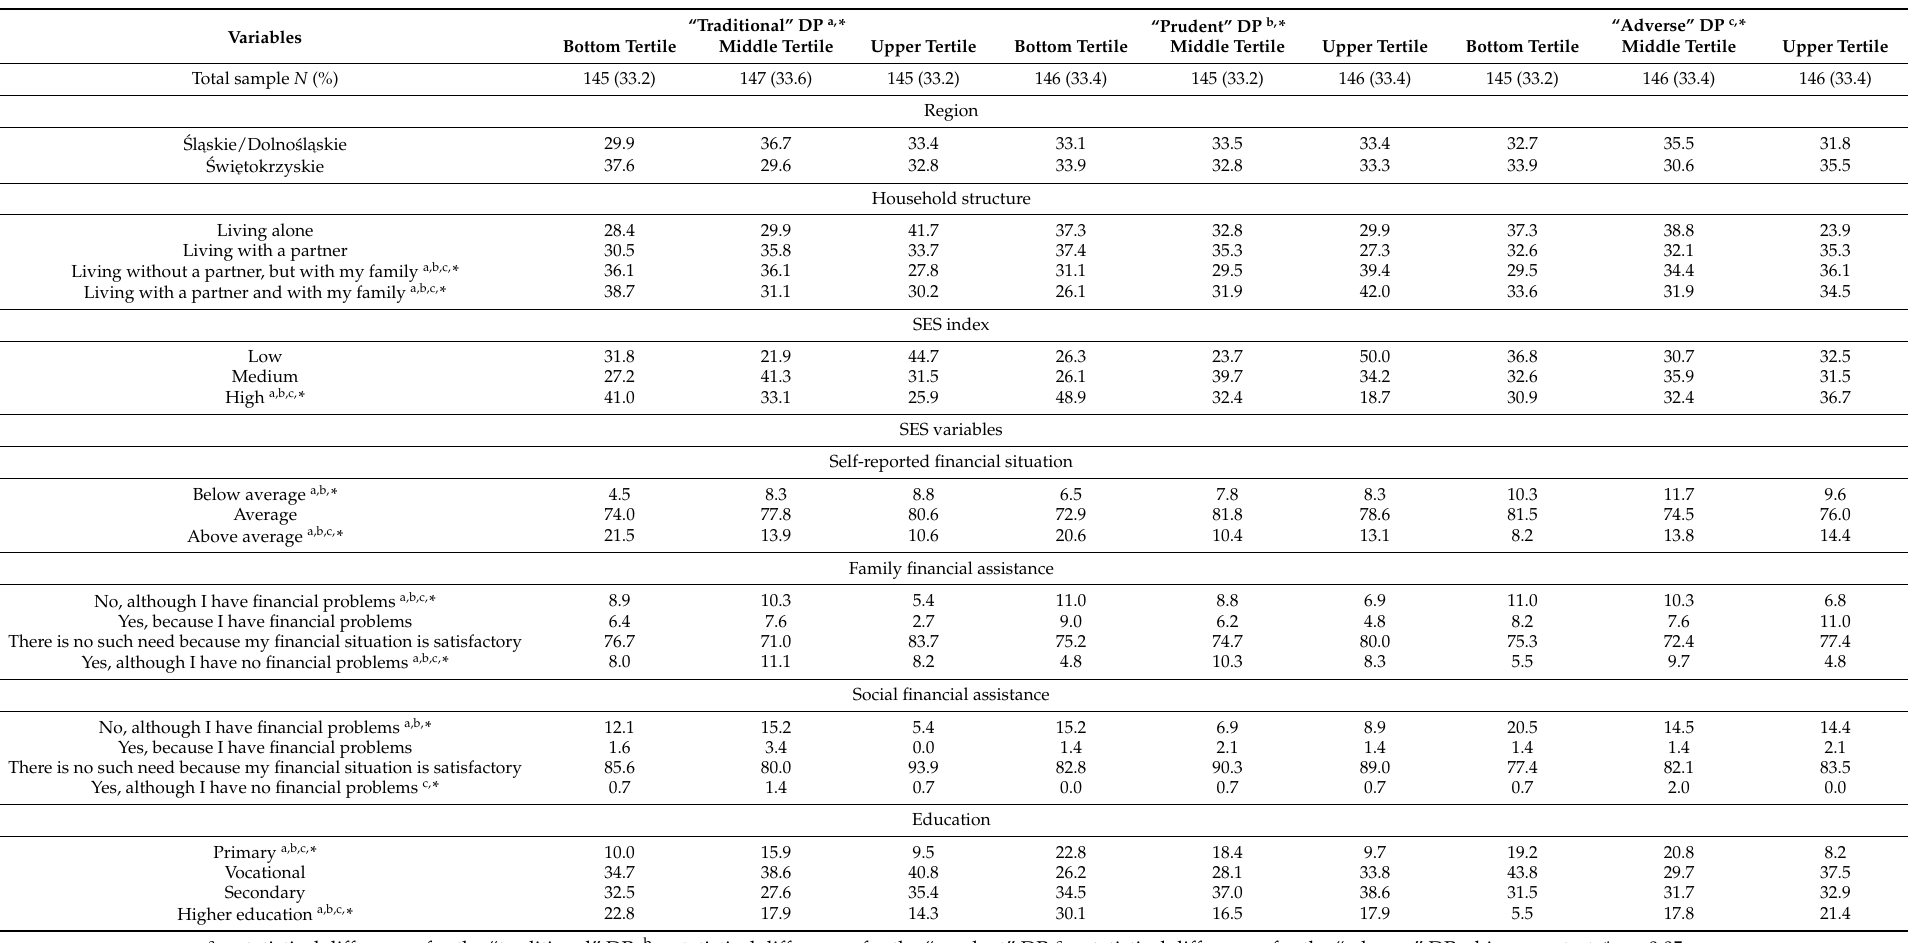
Table 3. Associations between dietary patterns and region, household status and SES index in the total sample (%). “Traditional” DP a, * “Prudent” DP b, * Variables Bottom